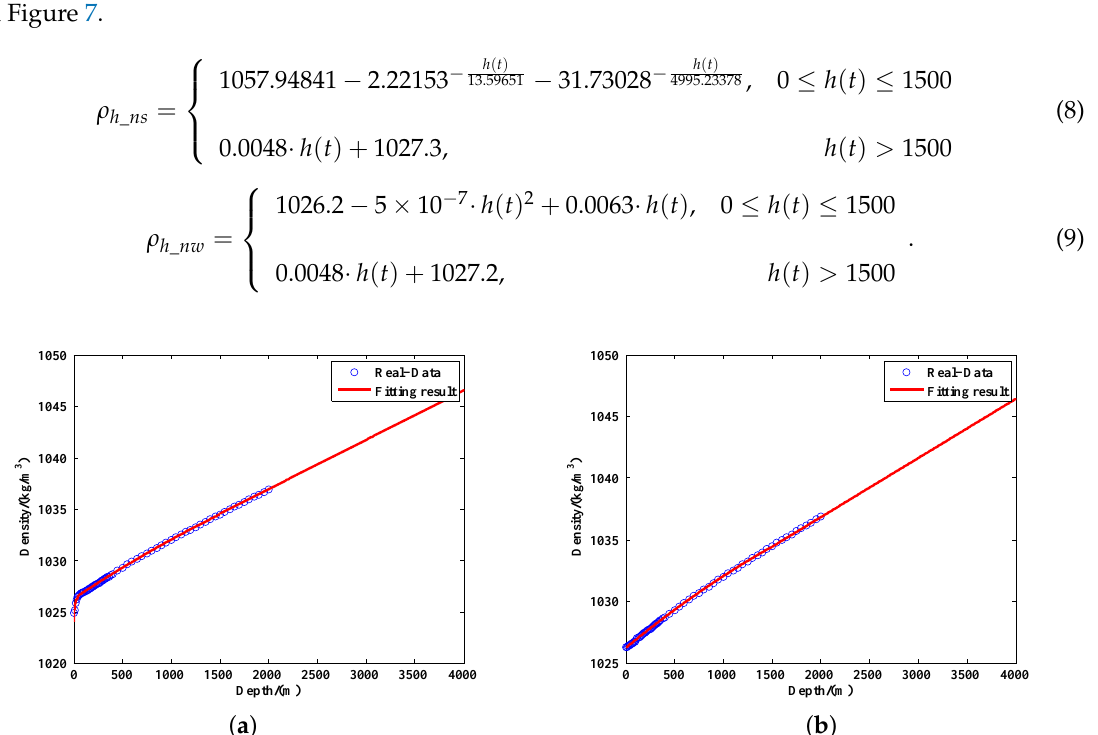
Figure 7. The fitting result of the density data in the nouthern hemisphere. Panel ( a ) shows the seawater’s density data in summer and ( b ) shows the seawater’s density data in